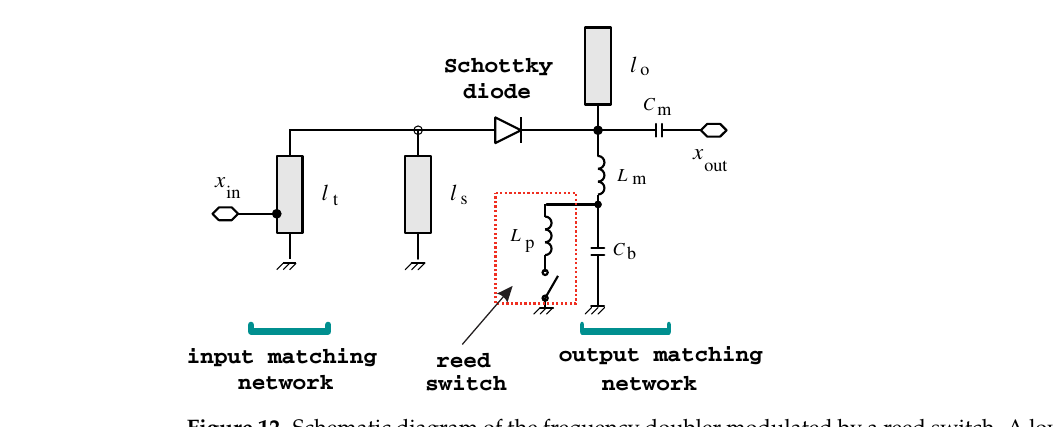
Figure 12. Schematic diagram of the frequency doubler modulated by a reed switch. A low-frequency reed switch for industrial application is used in the experiments. Lp models the parasitic switch inductance, including the connecting wires, and is on the order of µ H.